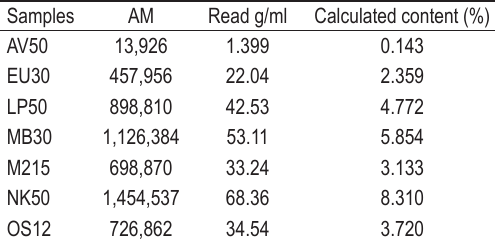
TABLE 6. Homosalate concentrations read from